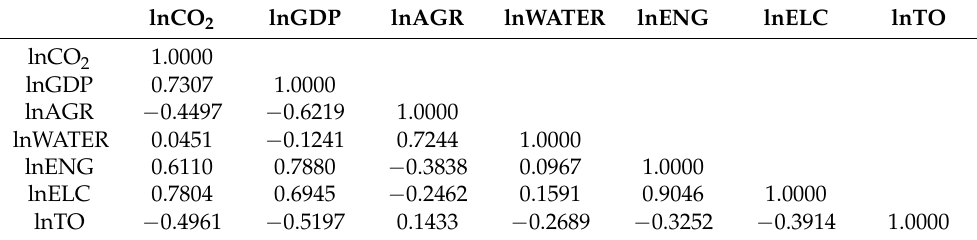
Table 3. Correlation